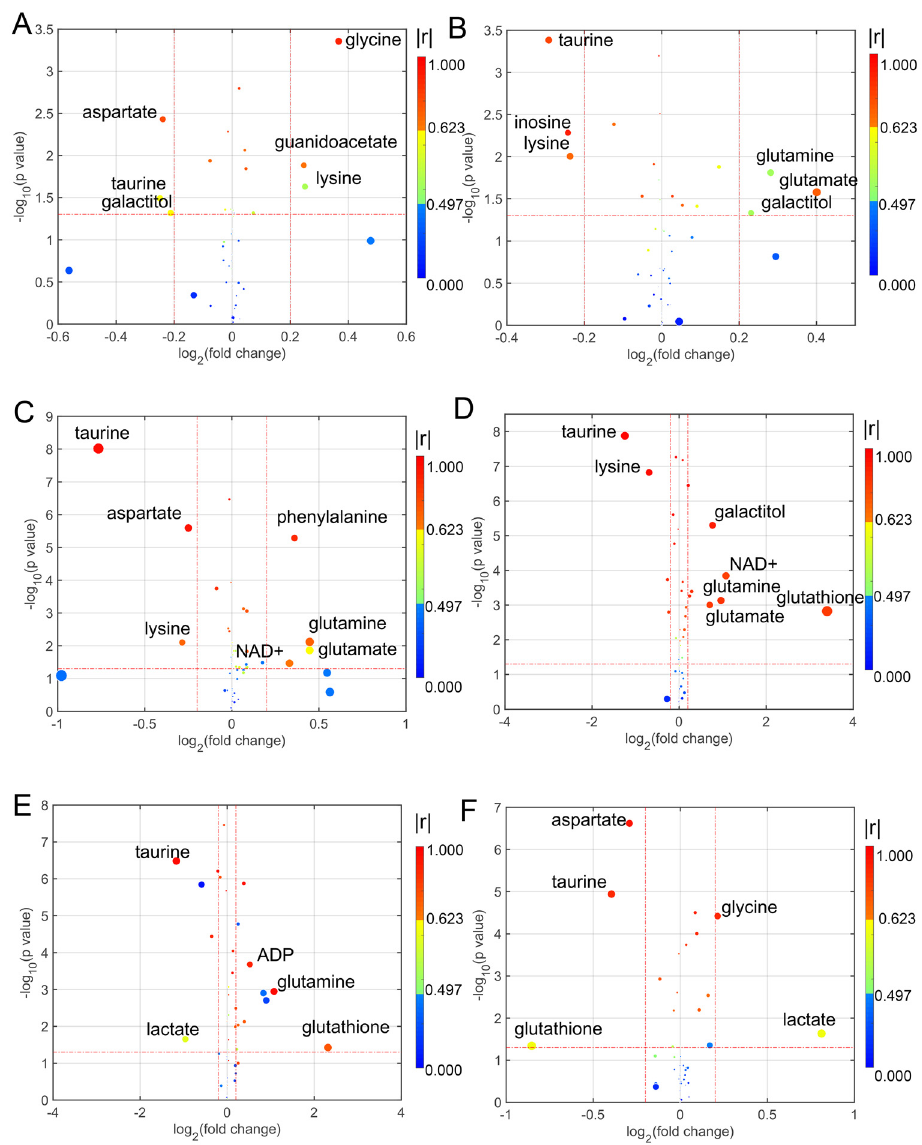
Figure 2. Enhanced volcano plots showing significantly different metabolites. ( A ) CD1 group vs. Control group; ( B ) CD2 group vs. Control group; ( C ) CD3 group vs. Control group; ( D ) CD4 group vs. Control group; ( E ) CD5 group vs. Control group; ( F ) CD6 group vs. Control group. Volcano plots show log 2 (fold change) on the x -axis and − log 10 ( p value) on the y -axis. Each point represents a metabolite. The circles’ size and color are determined based on the variable importance projection (VIP) and absolute correlation coefficient values (|r|), respectively. For each comparison, the larger the VIP value the larger the size of the circle, and the warmer color corresponds to higher |r|. The gradient blue means |r| is less than 0.497; the gradual bright yellow means |r| is greater than 0.497 and is less than 0.623; the gradient red means |r| is greater than